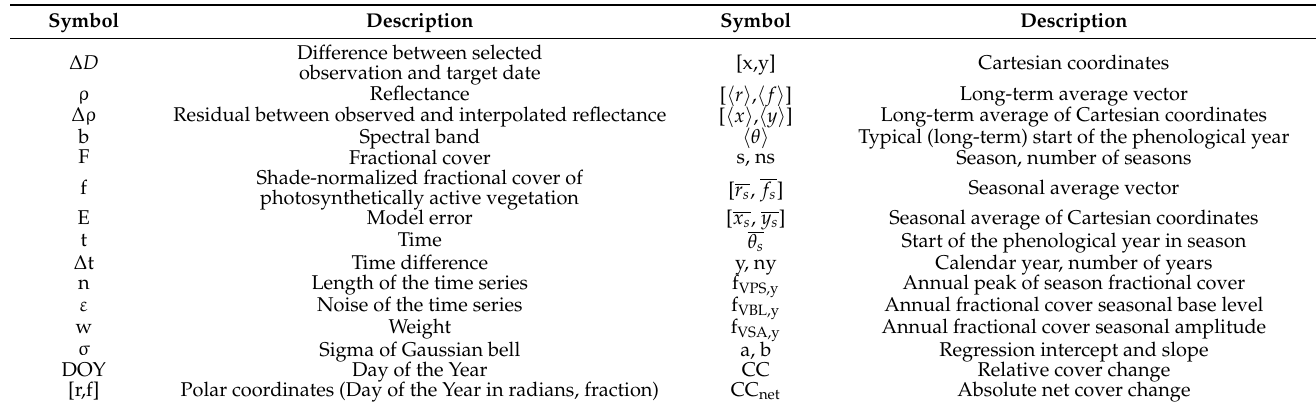
Table 1. Mathematical